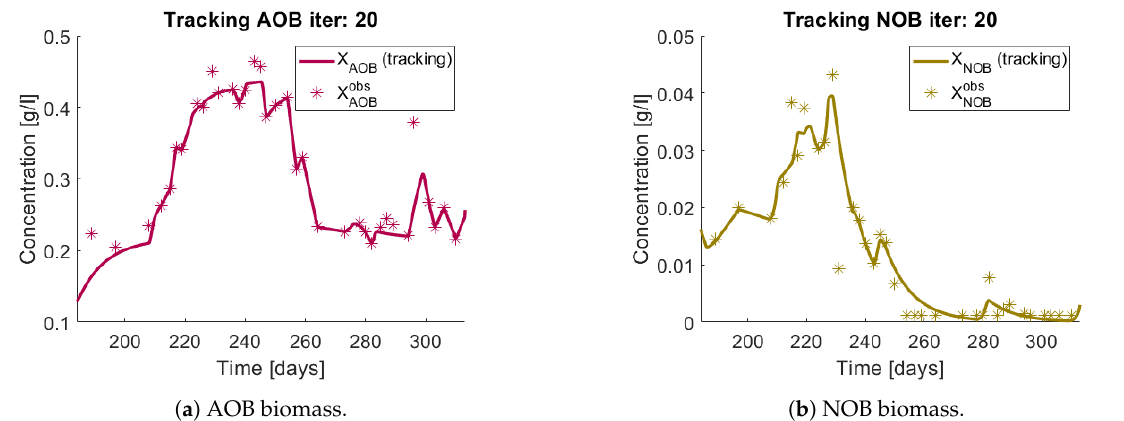
Figure 12. The tracking procedure applied to the observed biomass (asterisks) regrouped in two functional groups.